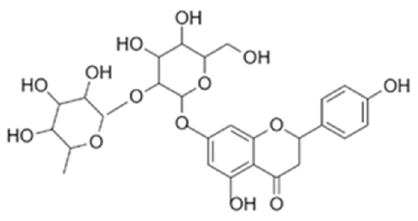
Figure 1. Chemical structure of